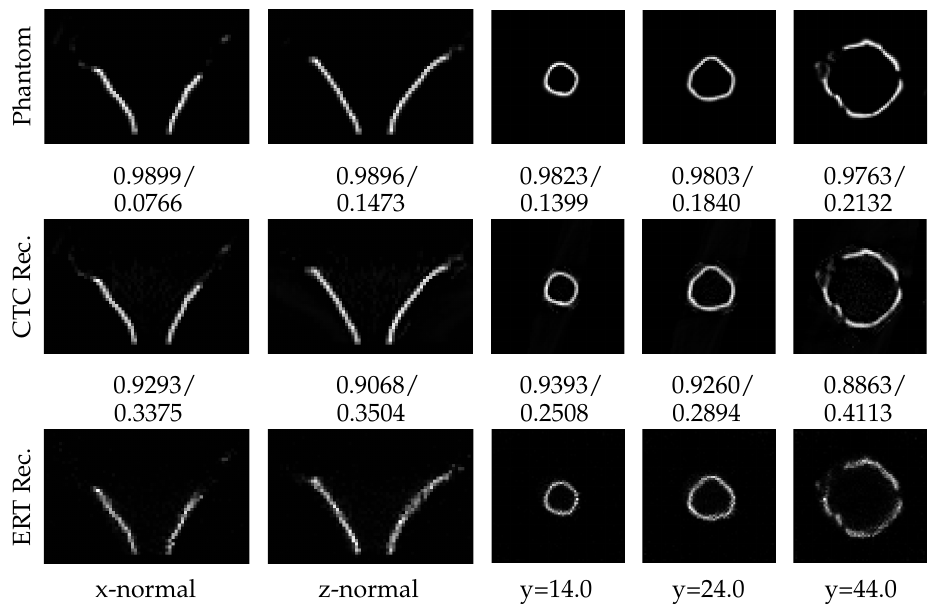
Figure 9. Slices normal to each spatial axis and height above burner exit (in mm), the correlation/normalized Manhattan distance to the phantom of each pair of slices is displayed between the images.